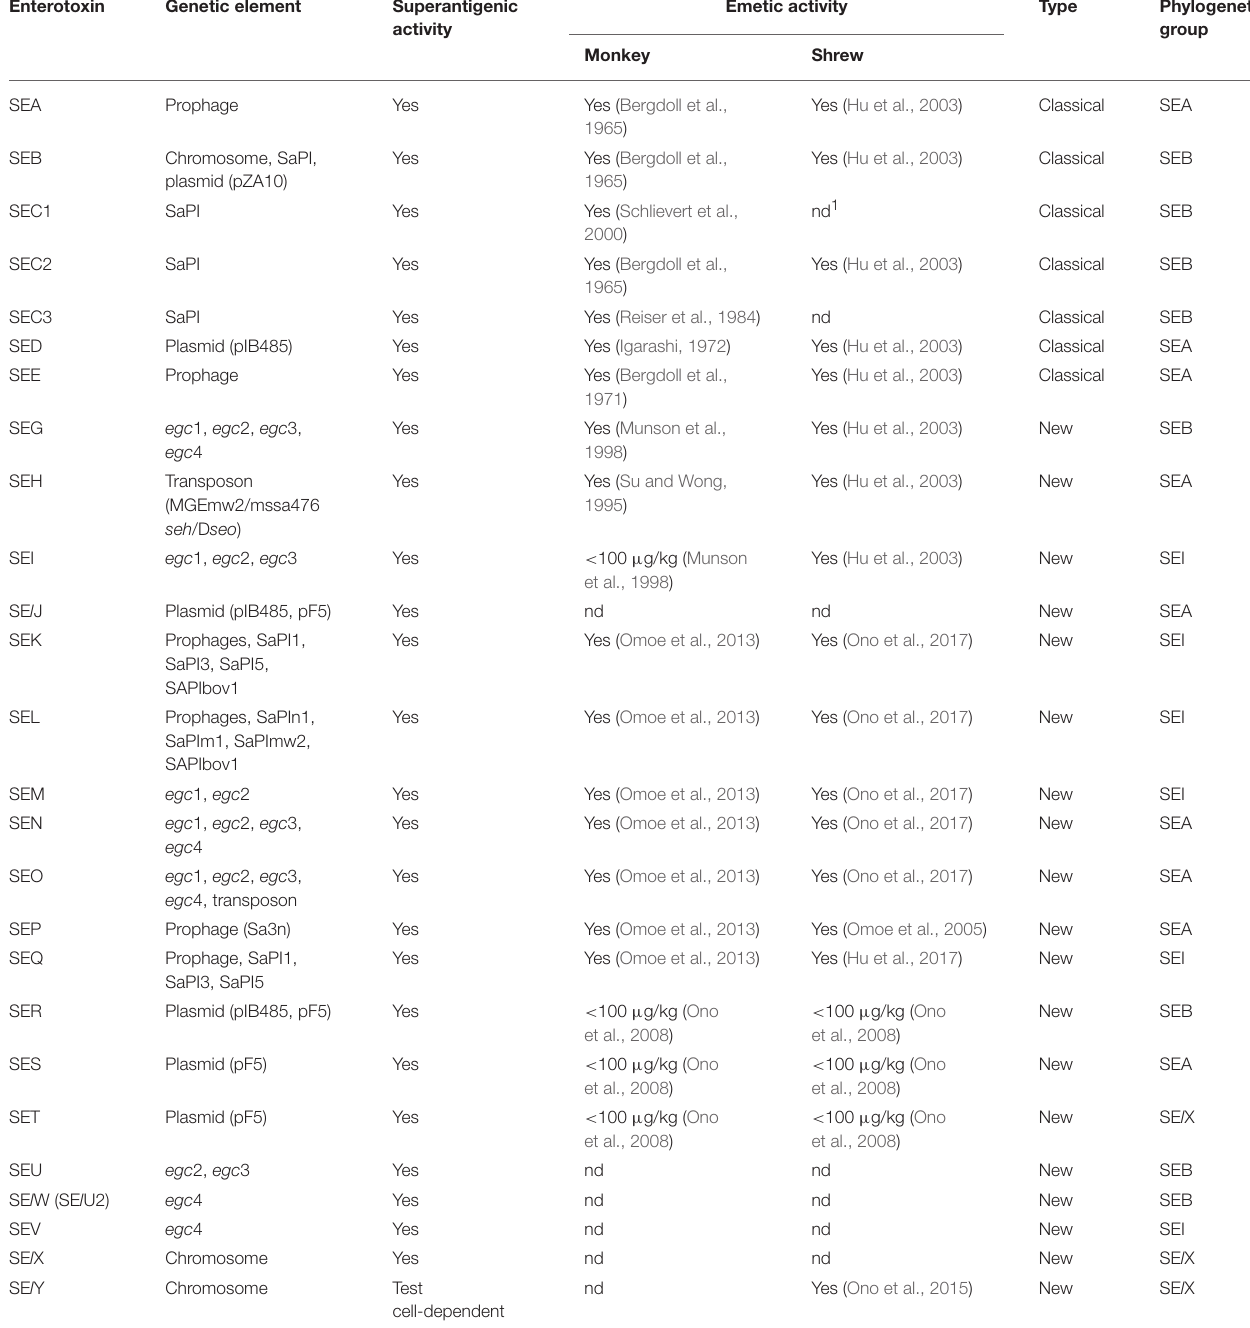
TABLE 1 | Emetic and superantigenic activities of staphylococcal enterotoxins.